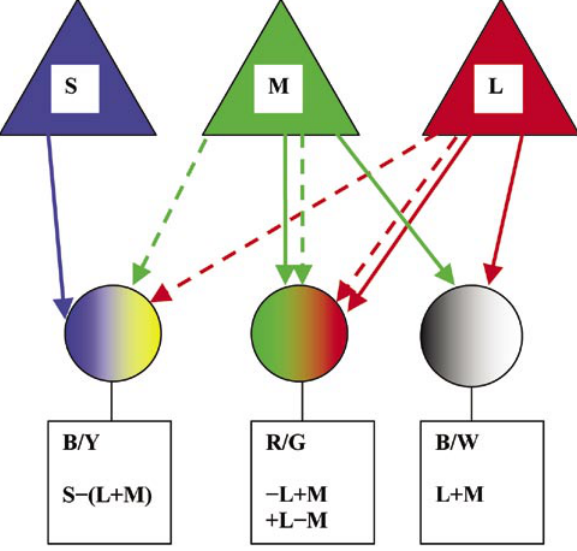
Figure 1 : An extremely simplified model of the early stages of the human colour sense is indicated. Sum- mation and subtractive characteristics of the retinal cones (triangles in the figure) and their input to the retinal ganglion cells (indicated with circles) and the lateral geniculate nuclei (indicated with squares) are suggested. Light stimulates the retinal photoreceptors and signals from the short (S), middle (M) and long (L) wavelength sensitive cones (indicated with